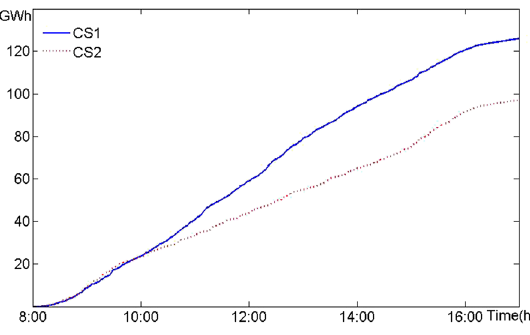
Fig. 12 The power mileages of an EV for CS1 and CS2